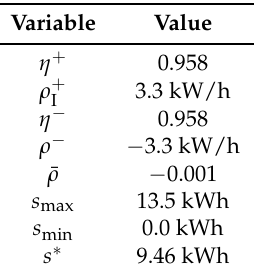
Table 1. Parameters for a Tesla-inspired [24] home battery storage system used throughout all simulations runs labelled with “RB